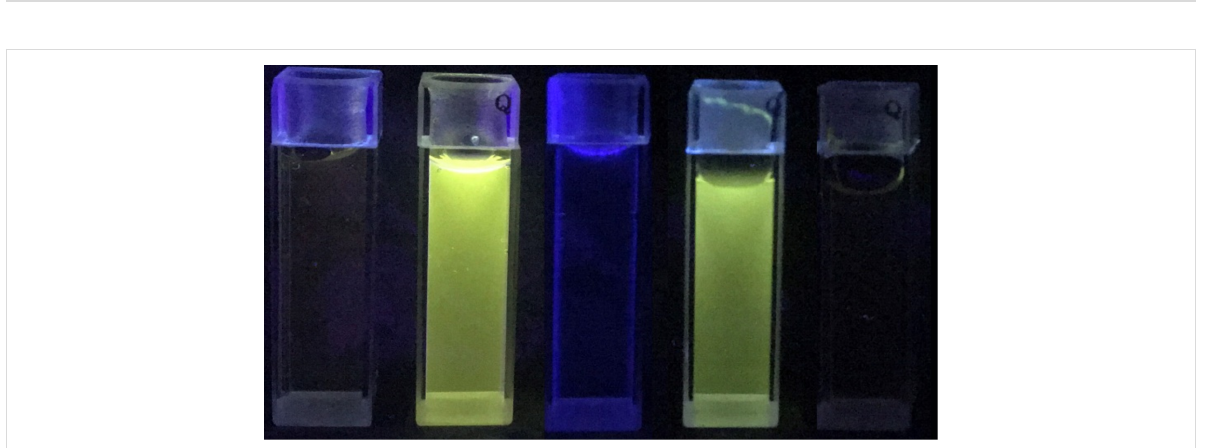
Figure 3: Visible emission observed from samples of P and B in the absence and presence of 2,2’-CBP4 under a UV lamp (365 nm). Left to right: P , P + 2,2’-CBP4, 2,2’-CBP4, B + 2,2’-CBP4 and B .